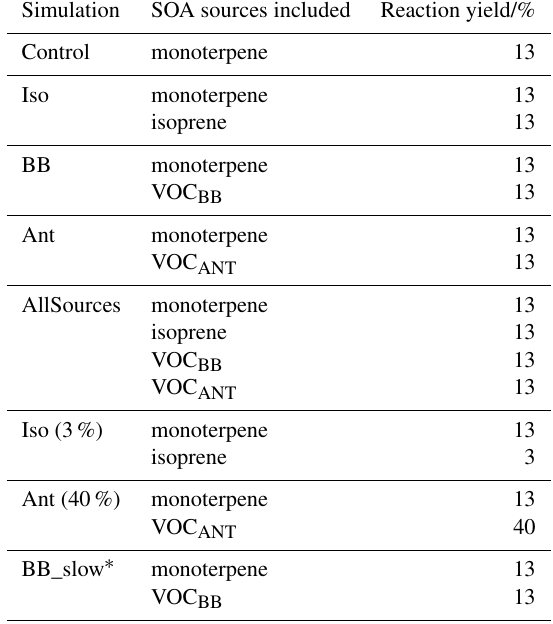
Table 2. Summary of simulations carried out in study. Reaction ki- netics for each source are shown in Table 1. For the BB_Slow simu- lation, VOC BB assumes the reactivity of naphthalene (Atkinson and Arey,